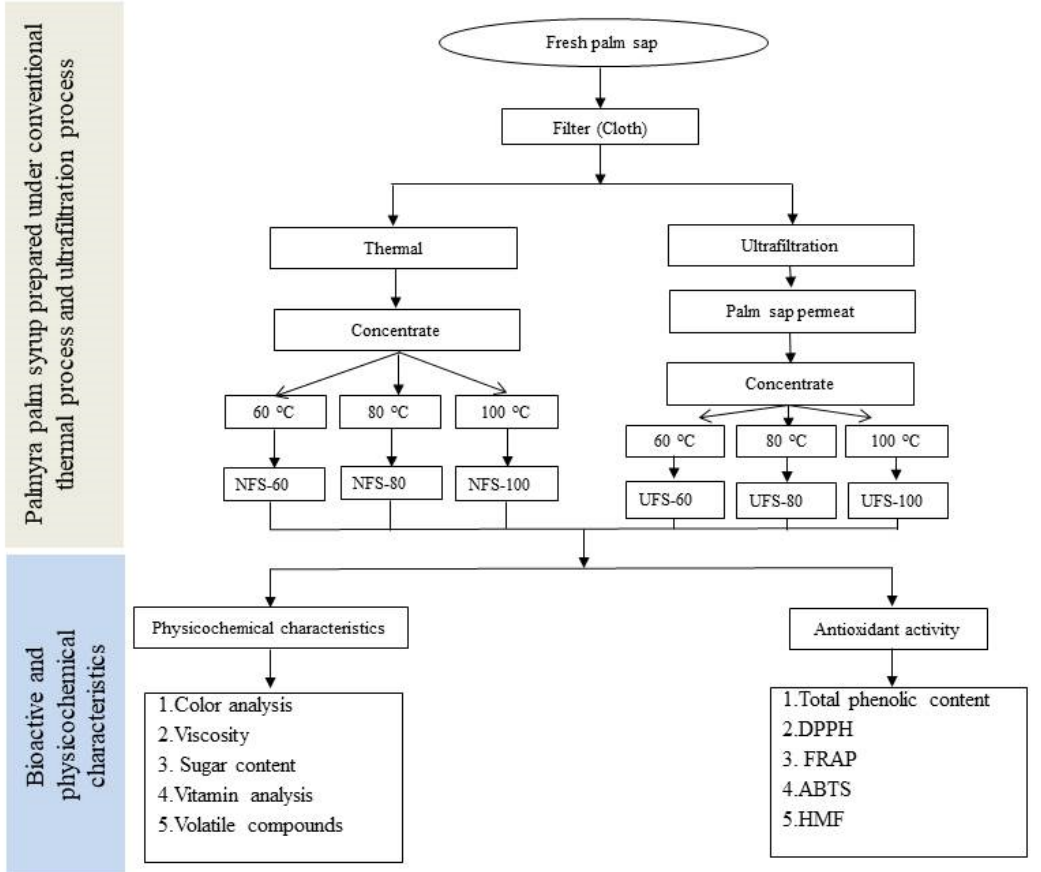
Figure 1. Diagram of preparation of palmyra palm